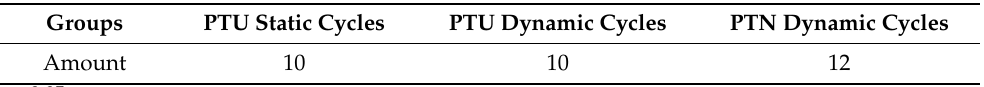
Table 3. The number of broken segments for each group.